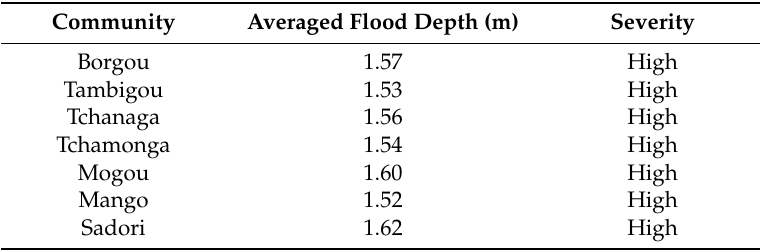
Community Averaged Flood Depth (m) Severity Borgou